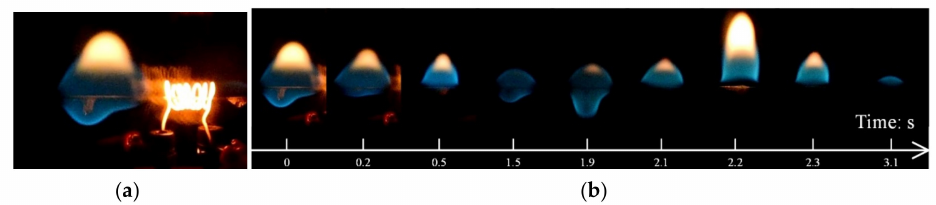
Figure 5. The flame morphology along with the time at 20.0 kPa: ( a ) dripping occurred just behind the ignition and ( b ) the dripping and flame extinction